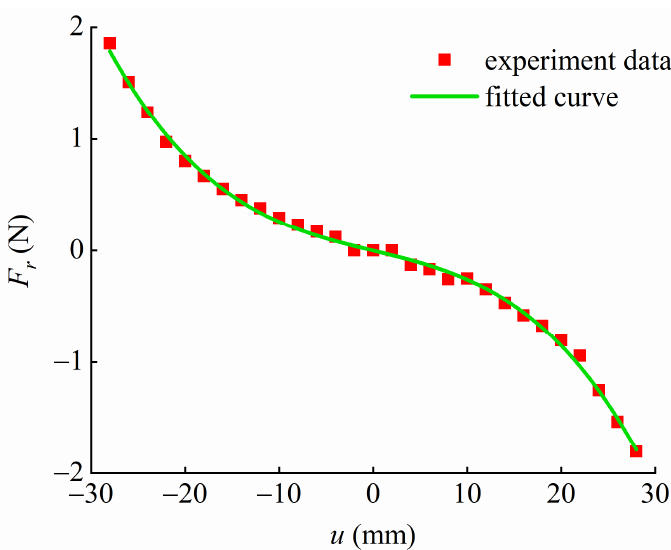
Figure 3. Resilience fitting results.